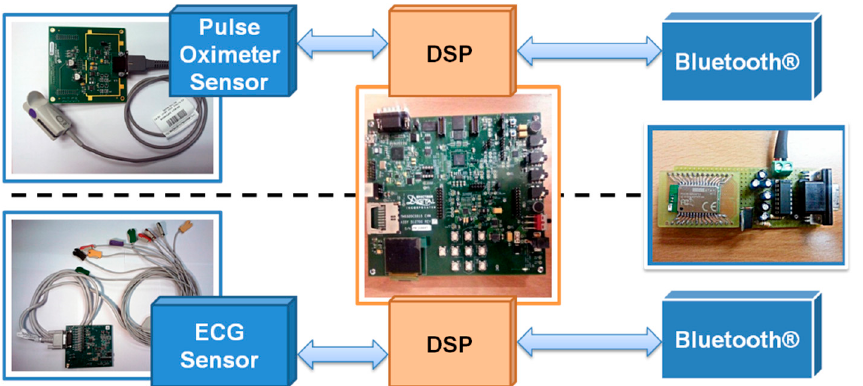
Figure 3. Architecture of the IEEE agent in our framework showing the acquisition, processing, and transmission hardware.